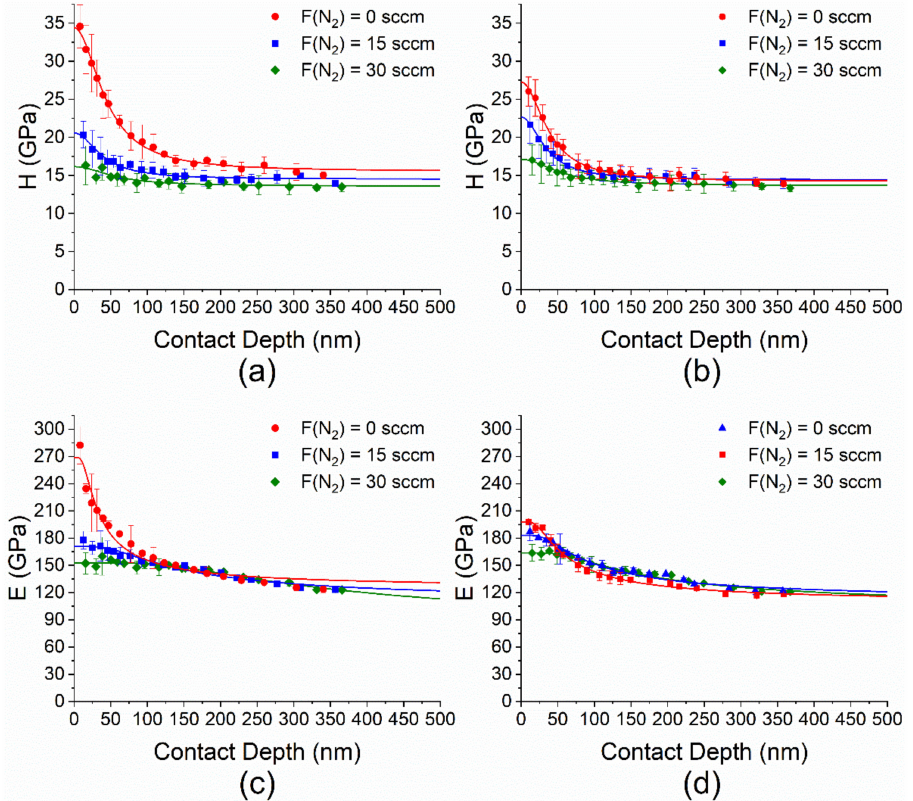
Figure 9. Hardness ( a , b ) and elastic modulus ( c , d ) of SiC x N y samples as functions of the indenter penetration depth at the different nitrogen flow rate. T dep = RT ( a , c ) and 300 ◦ C ( b , d